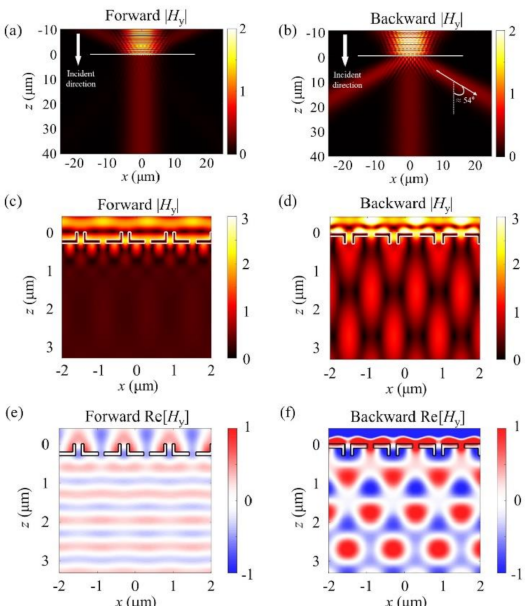
Figure 2. ( a , b ) H y field distribution of ( a ) forward and ( b ) backward illumination cases when the Gaussian beam is normally incident on the proposed structure. The white arrow indicates the direction of the incident light, and the horizontal line indicates the location of the proposed structure. ( c , d ) Absolute value of the magnetic field in the ( c ) forward and ( d ) backward illumination cases near the nanoslit array. ( e , f ) Calculated real part of the magnetic field distribution ( e ) without diffraction (Forward Re[ H y ]) and ( f ) with diffraction (Backward Re[ H y